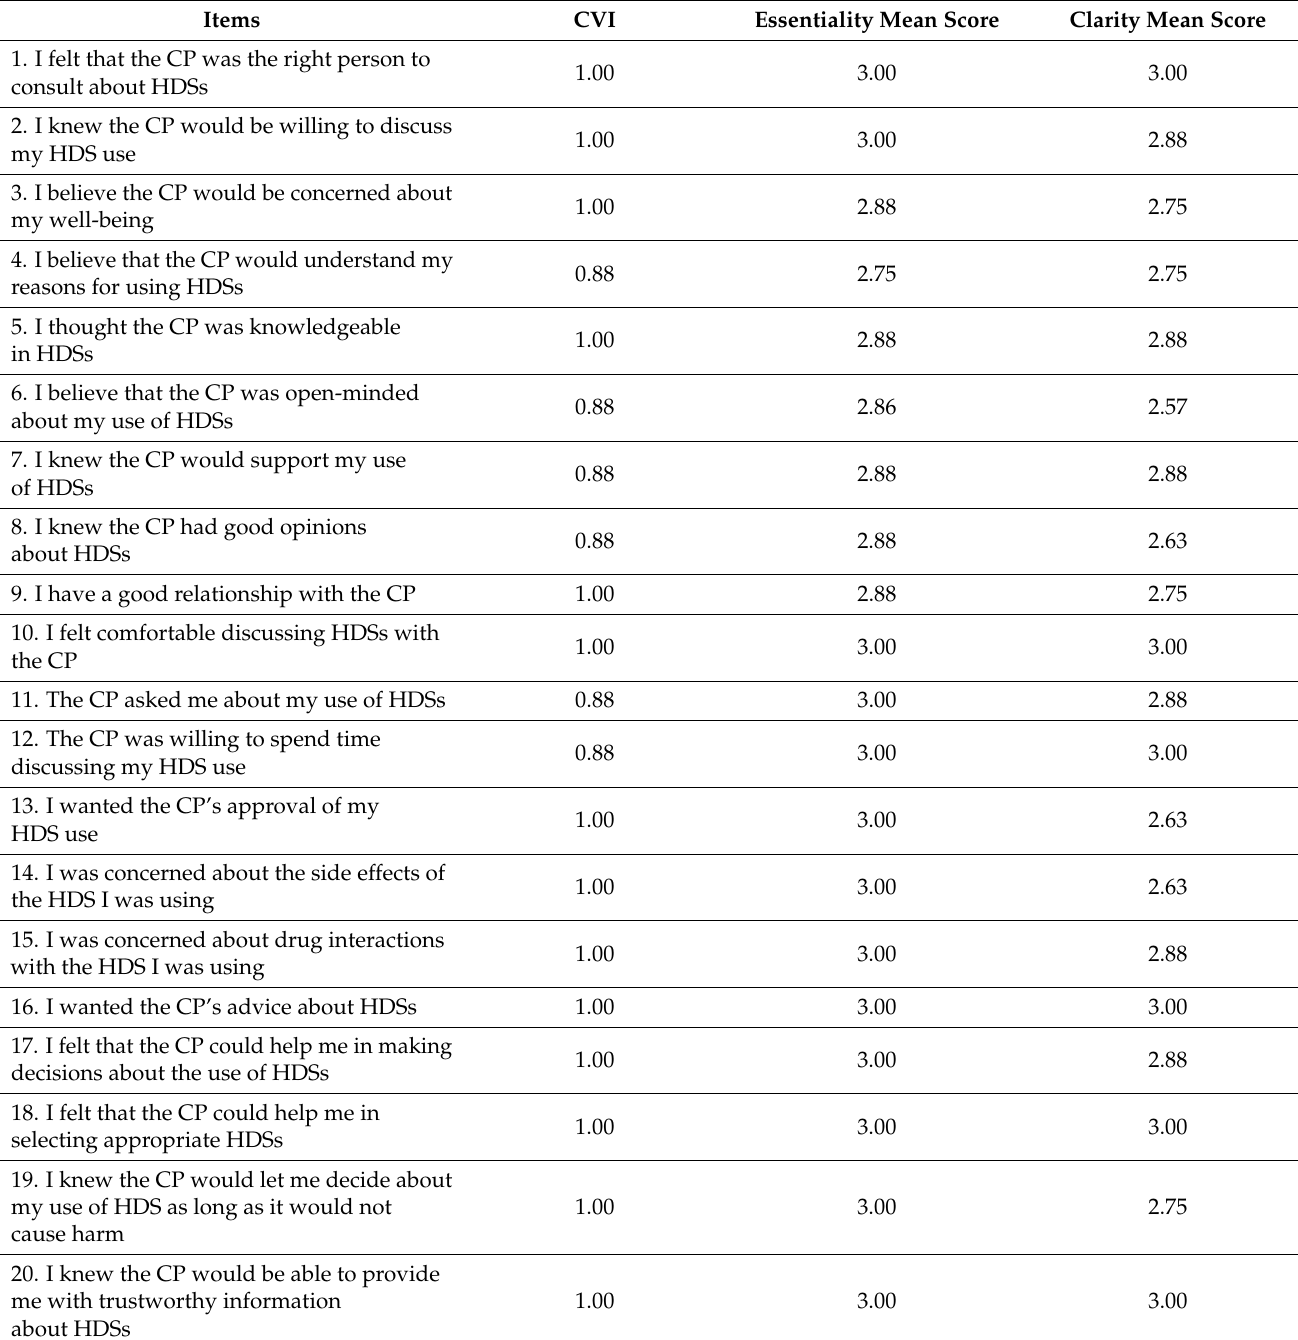
Table A3. Content Validity Index (CVI), and Mean “Essentiality” and “Clarity” Scores of “Reasons for Consulting CPs about HDS Use”